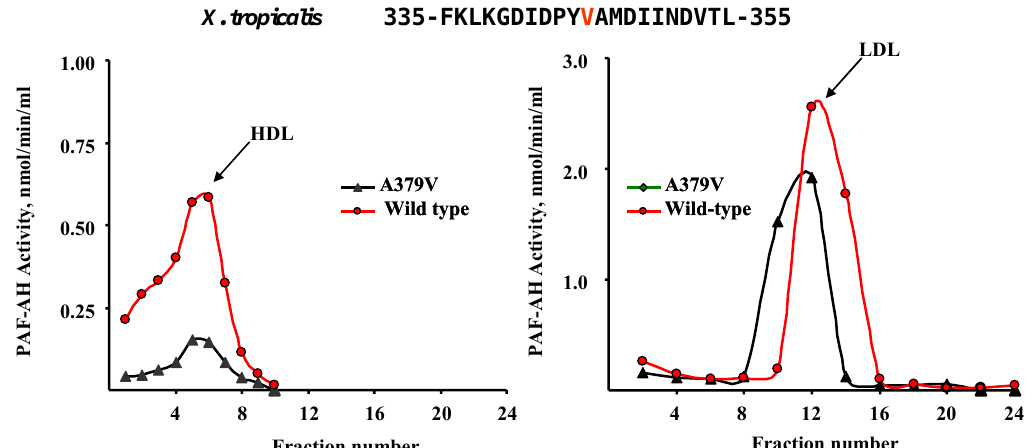
The top panel depicts amino acid sequences around A379 across several species. The bottom panels show that recombinant human A379V binds to HDL (left panel) and LDL (right panel) in manners comparable